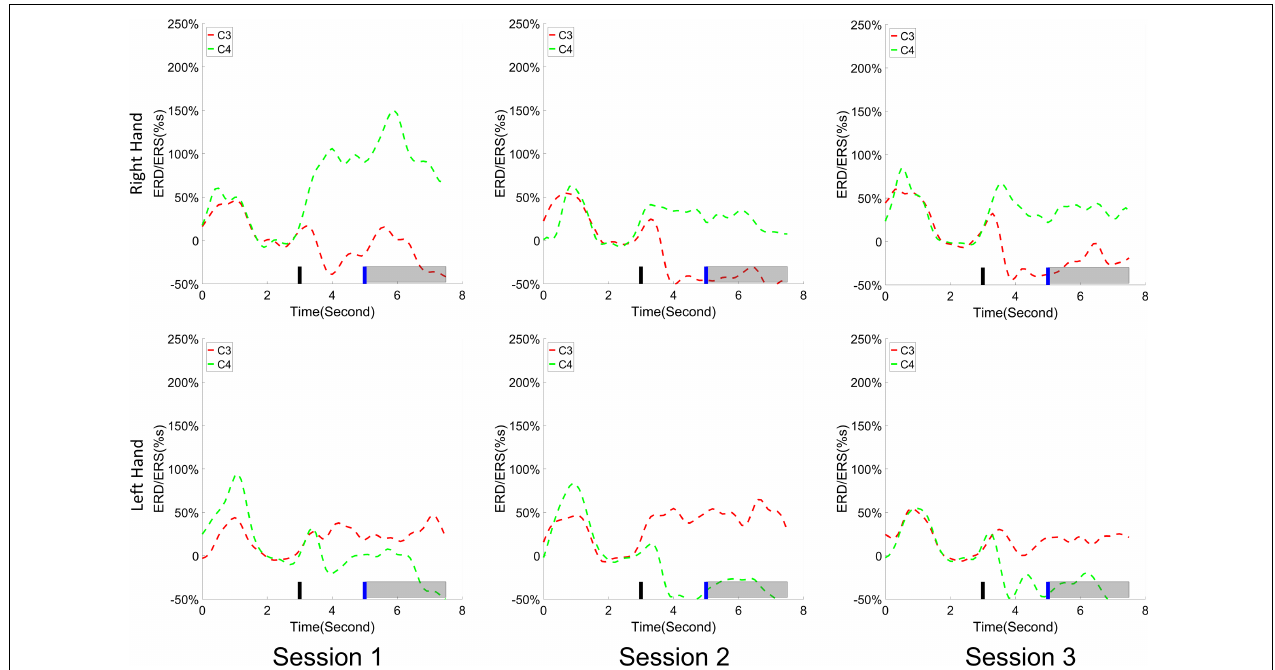
FIGURE 10 | An individual example (Subject 3) of the time varying average ERD/ERS value for the right hand task (the first row) and the left hand task (the second row) across the training sessions. Shown is the similar convention to the group average results. A strong ERD on the contralateral hemisphere and a moderate ERS on the ipsilateral hemisphere was observed especially in the latter two